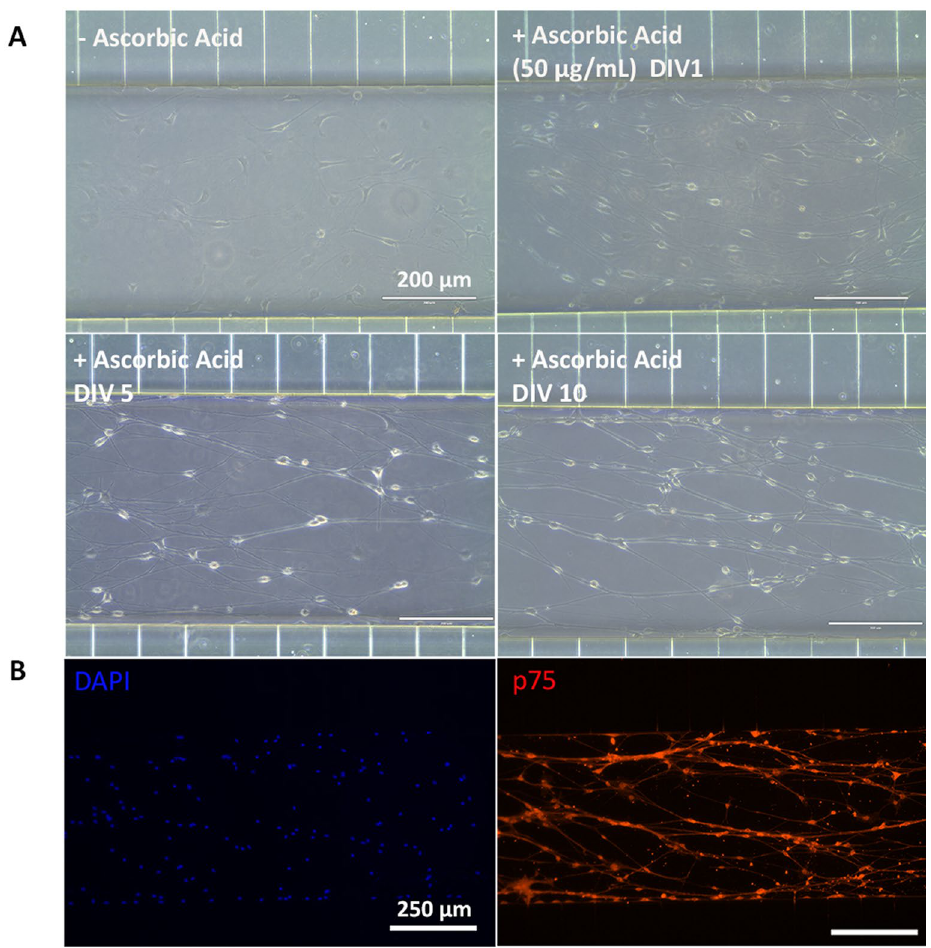
Figure 7. Induction of primary rat Schwann cells towards a myelinating phenotype in microfluidic device in flow condition. ( A ) Phase contrast images of primary rat Schwann cells before treatment with ascorbic acid and under differentiation at DIV1, DIV5 and DIV10 of incubation with ascorbic acid (50 µg/mL). Scale bar 200 µm. ( B ) Fluorescent images of p75 neurotrophin receptor p75 stained induced primary rat Schwann cells at DIV10. Scale bar: 250